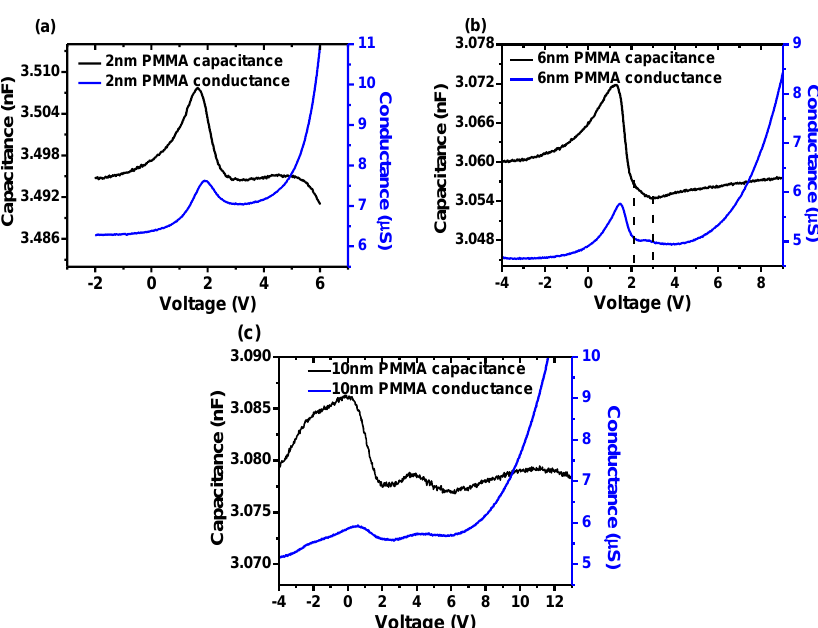
Figure 4. The C-V and G-V characteristics under illumination of devices with PMMA thickness of ( a ) 2 nm ( b ) 6 nm ( c ) 10 nm.